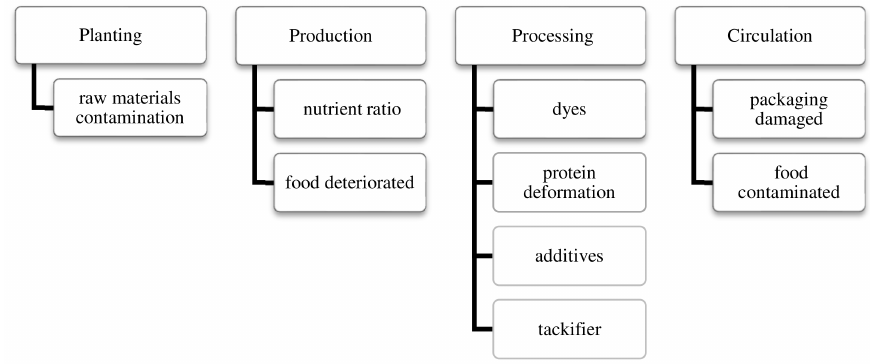
Figure 1. Sources of hazard in the manufacturing and distribution of PM products.